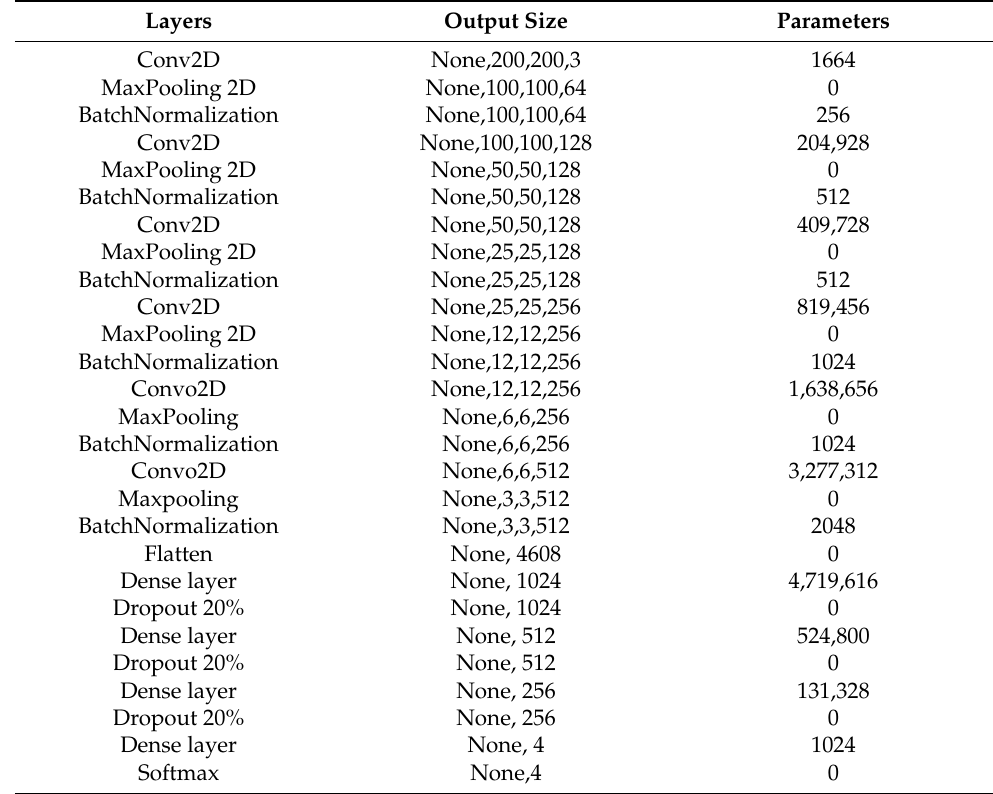
Table 2. The layers of the proposed